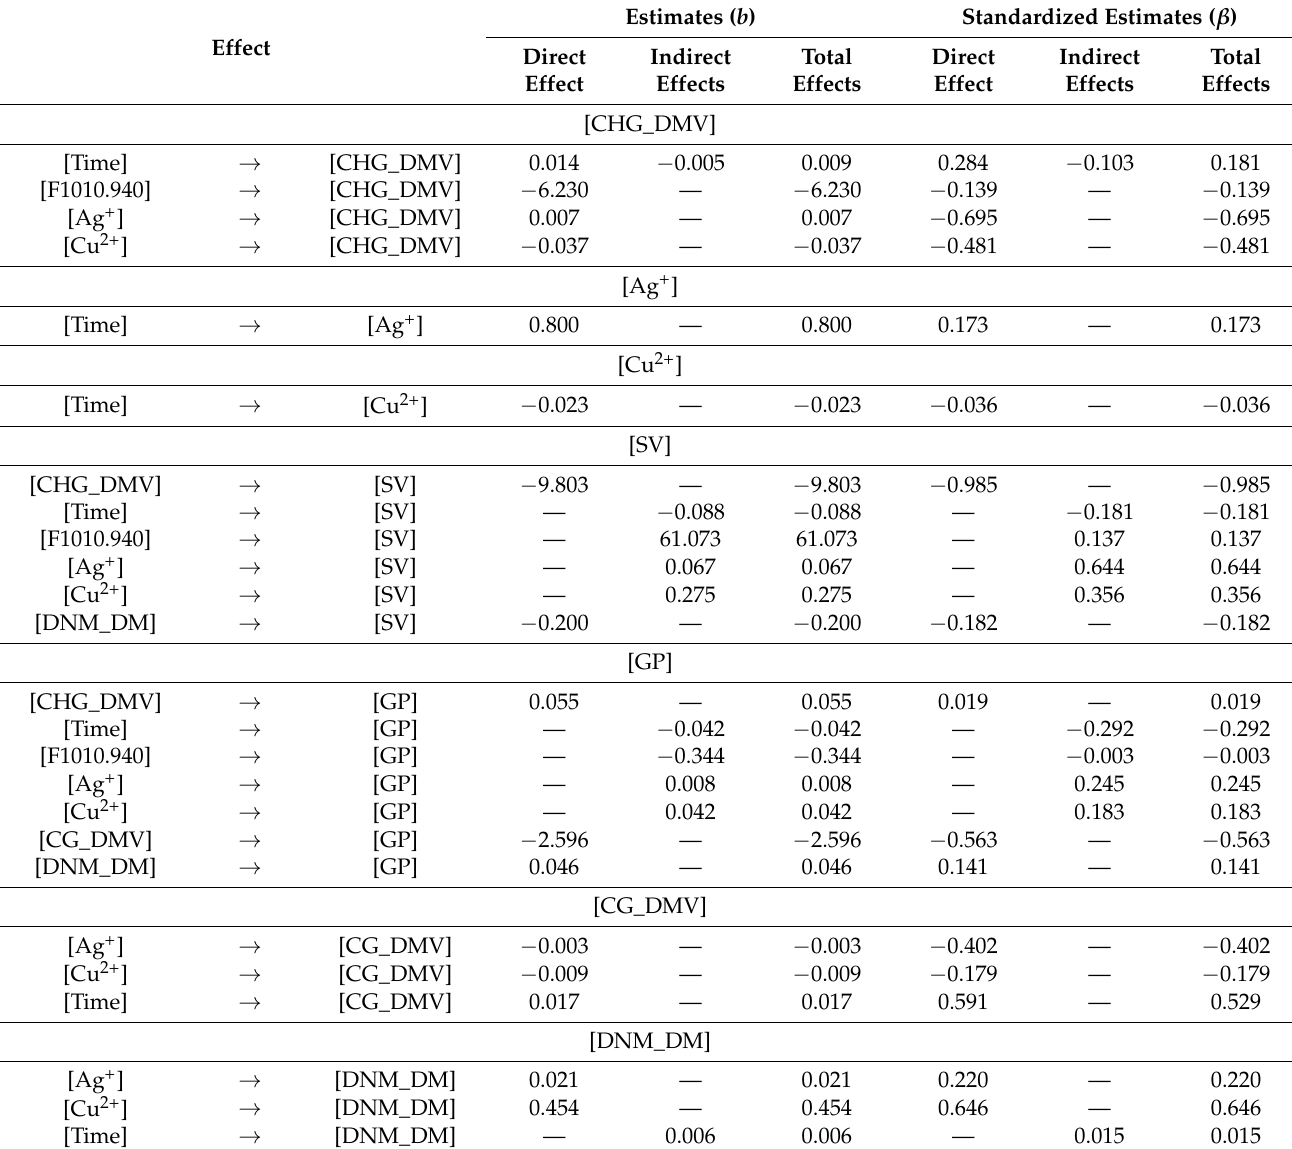
Table 5. Direct, indirect and total effects for the analyzed